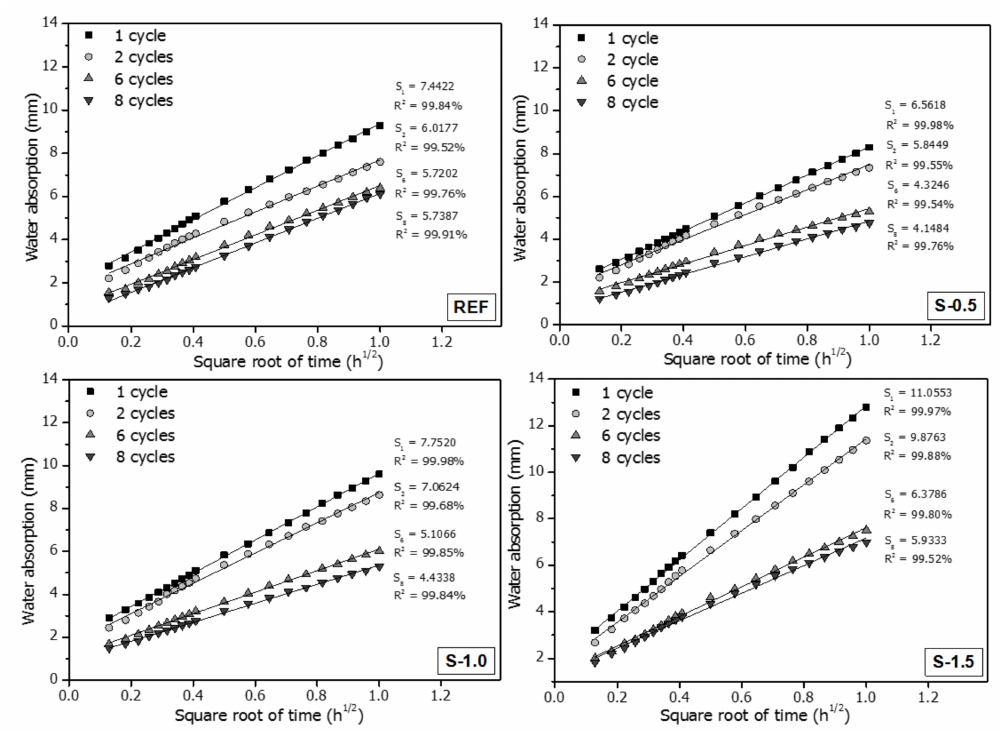
Figure 5. Water absorption of specimens over the square root of time, for different numbers of